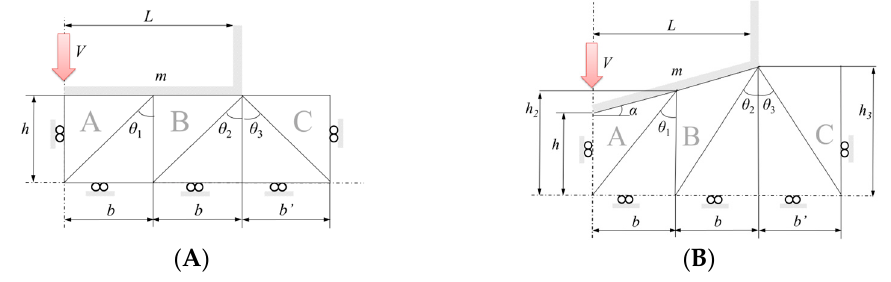
Figure 2. Flat ( A ) and inclined ( B ) punch Modular Upper Bound (MUB) application. h is the height, b/b’ is the base and θ i is the angle of the modules, m is the friction coefficient, α is the angle and L is the length of the punch, represented each module with a letter.